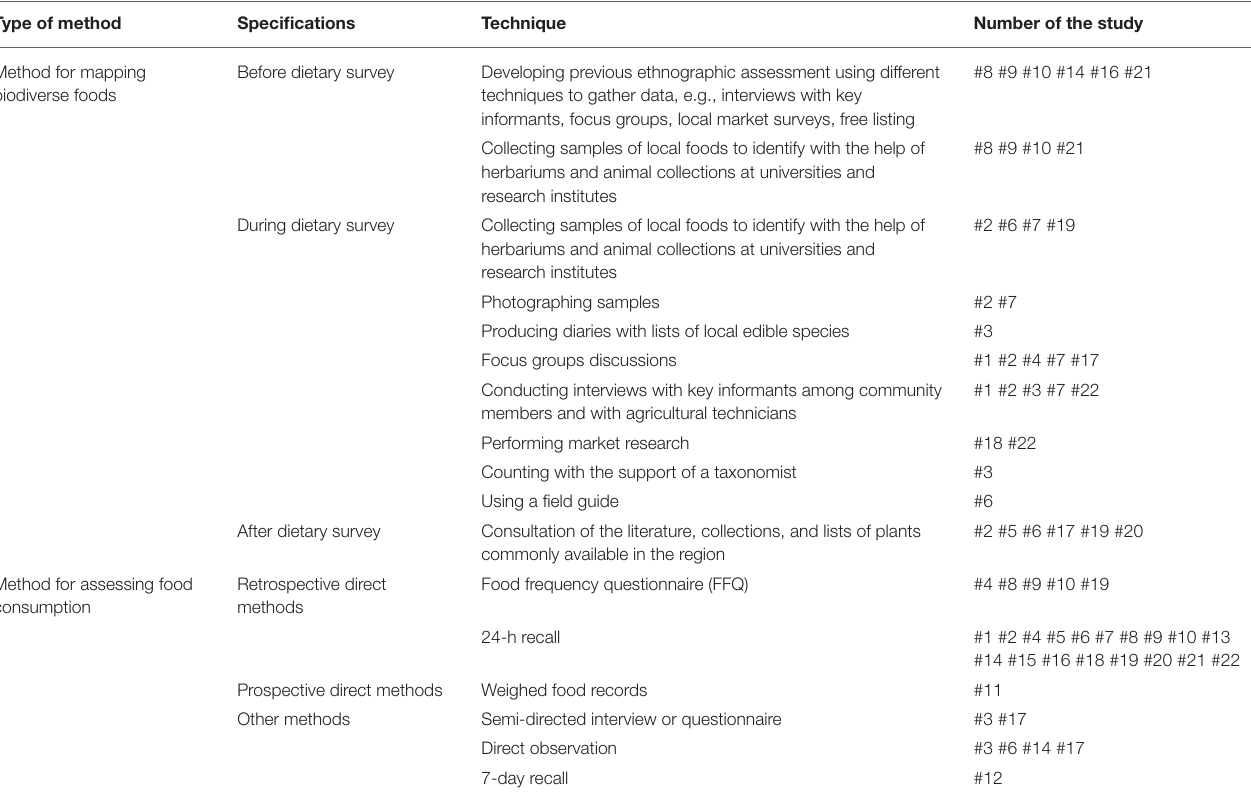
TABLE 2 | Summary of methods applied to biodiversity assessment in food consumption